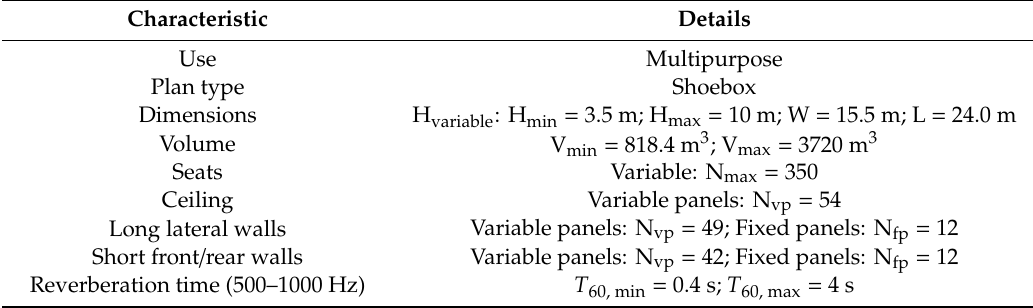
Figure 1. Surface acoustic conditions absorptive, reflective, and diffusive (A, R, and D). Interior view and simplified models of the eight configurations of the hall. Six configurations tested with three different locations of the diffusive surfaces (Df-A, Dm-A, Dr-A, Df-R, Dm-R, Dr-R) and two reference conditions (All-A and All-R). Table 1. Architectural and acoustical details of the ESPRO based on Peutz [27,28].